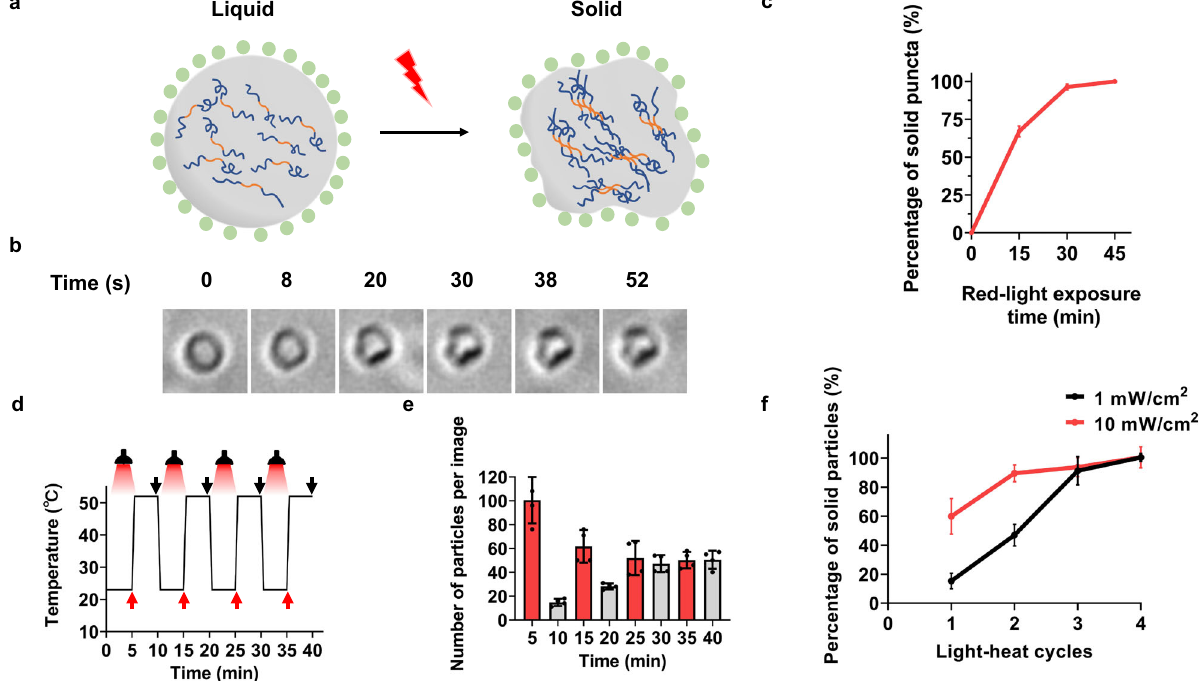
Fig. 4 Red-light-dependent liquid-to-solid phase transition of RMR/WSCP condensates. a Schematic illustration of red-light-induced liquid-to-solid phase transition process. b Appearance of an RMR/WSCP condensate at 23 °C under irradiation with the passage of time. Images representative of n > 10. c Percentages of solid particles throughout red-light irradiation with the passage of time. Solid particles were differentiated from the spherical liquid condensates based on their irregular shapes (Supplementary Fig. 3). Data are presented as mean ± SD ( n = 3). d Schematic showing light-heat cycling experiments that comprise iterative red-light irradiation at 23 °C (5 min, 1 mW/cm 2 ) and ensuing incubation at 52 °C in the dark (5 min). Images were taken at time points as indicated by red and black arrows. e Number of solid particles observed per image. Data are presented as mean ± SD ( n = 4). f Percentage of heat-resistant solid particles observed after each light-heat cycle. Data are presented as mean ± SD ( n =